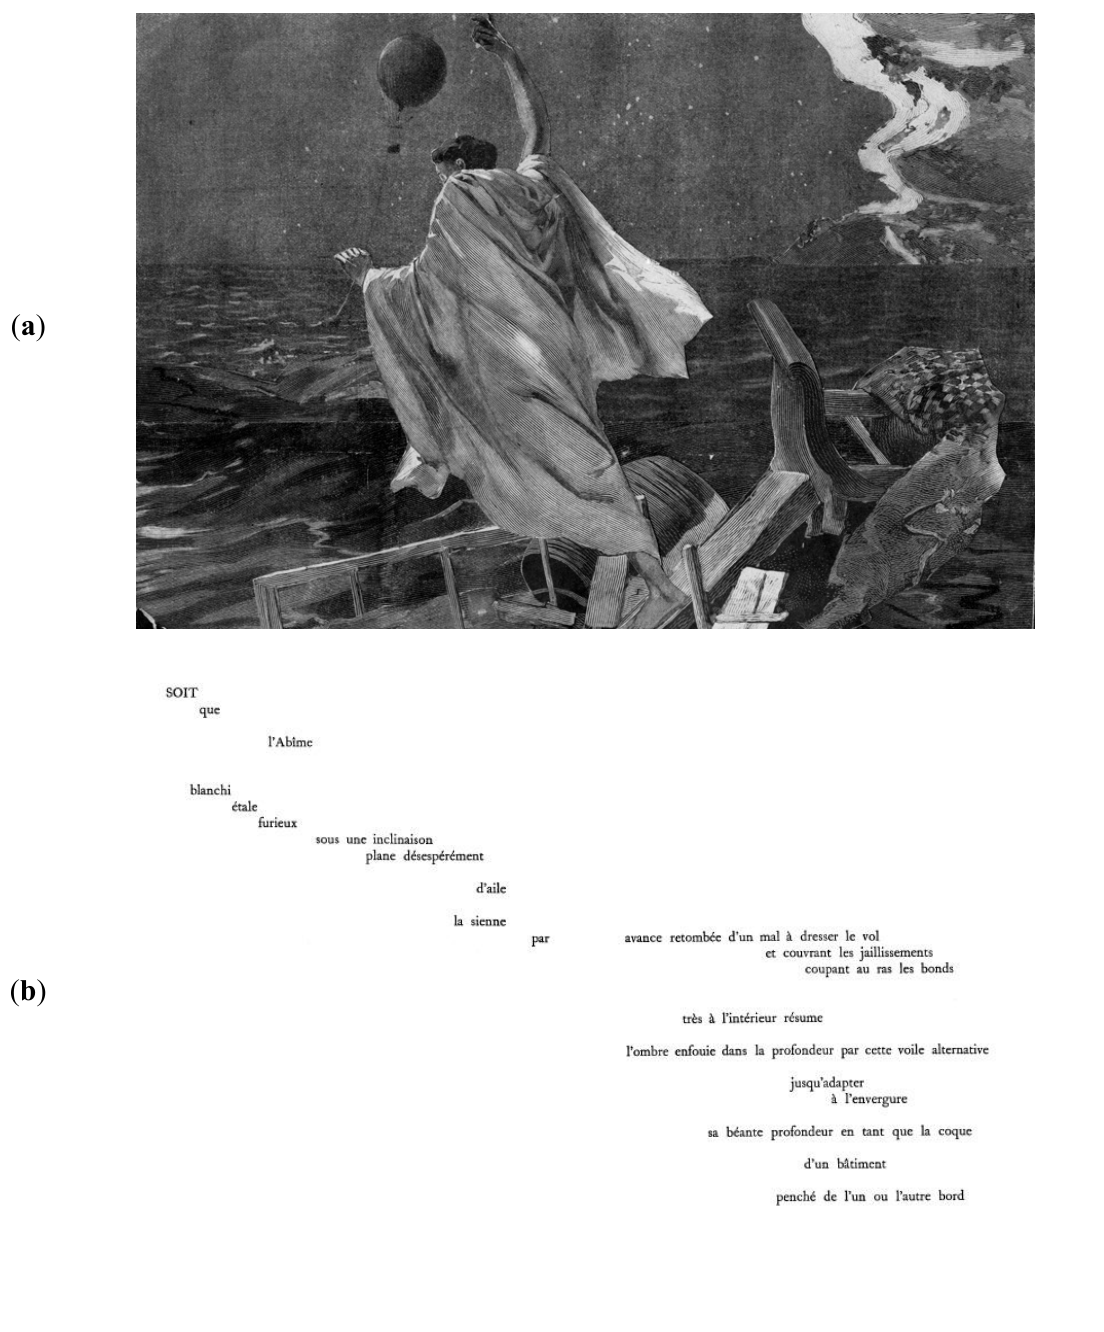
Figure 4. ( a ) Paper Collage comprised of original engravings from La Grande Illustré (1904); ( b ) extract from Un Coup des Dés: CAN ONLY BE/the Abyss/raging/whitened/ stalled/beneath the desperately sloping incline/of its own wing/through an advance falling back from ill to take flight/and veiling the gushers/restraining the surges